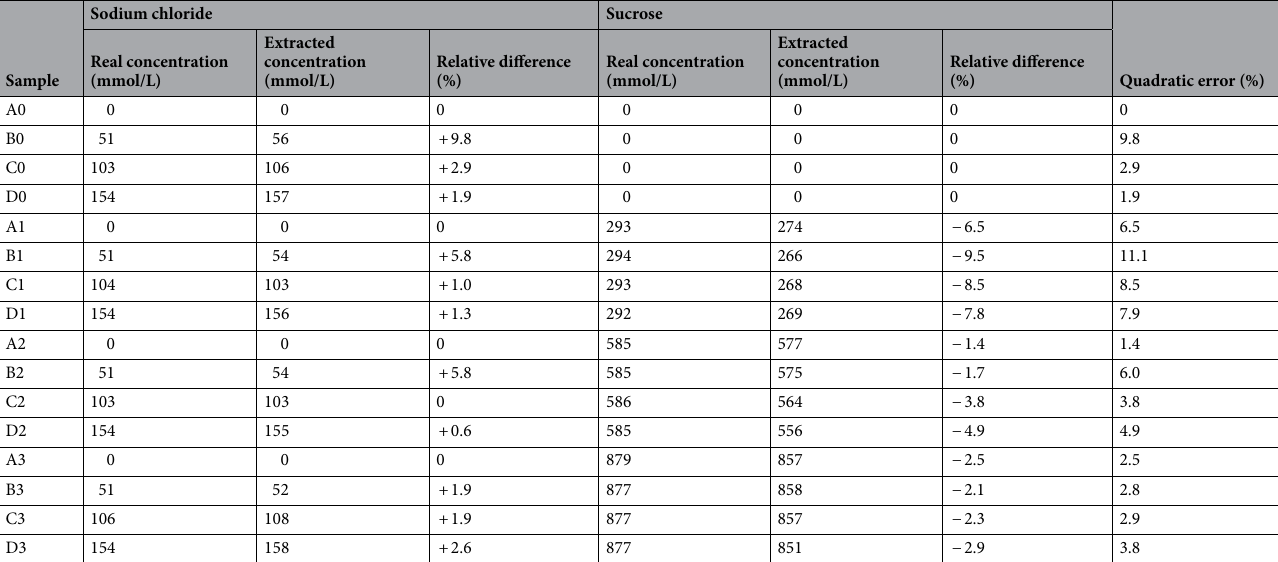
Table 6. Summary of the real and extracted concentrations and their relative